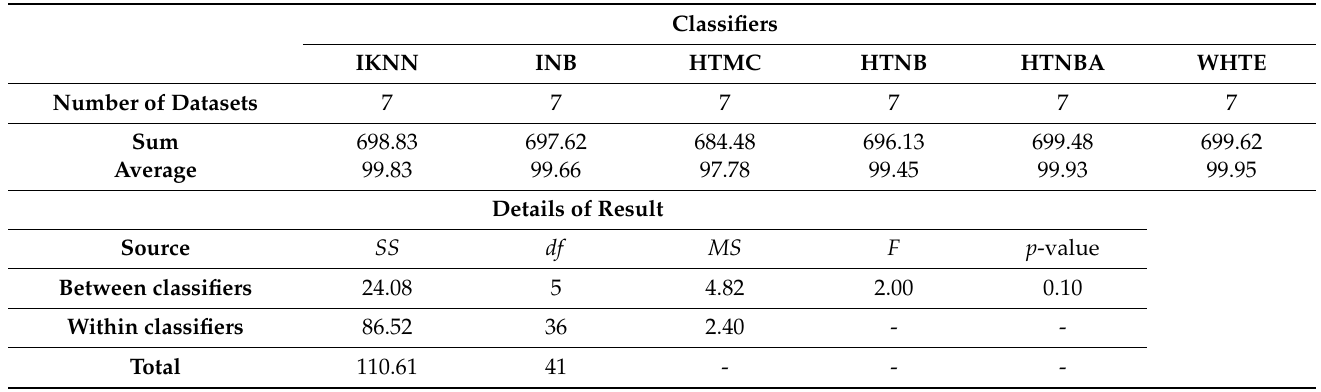
Table 4. The ANOVA test results, where accuracy is the independent variable.